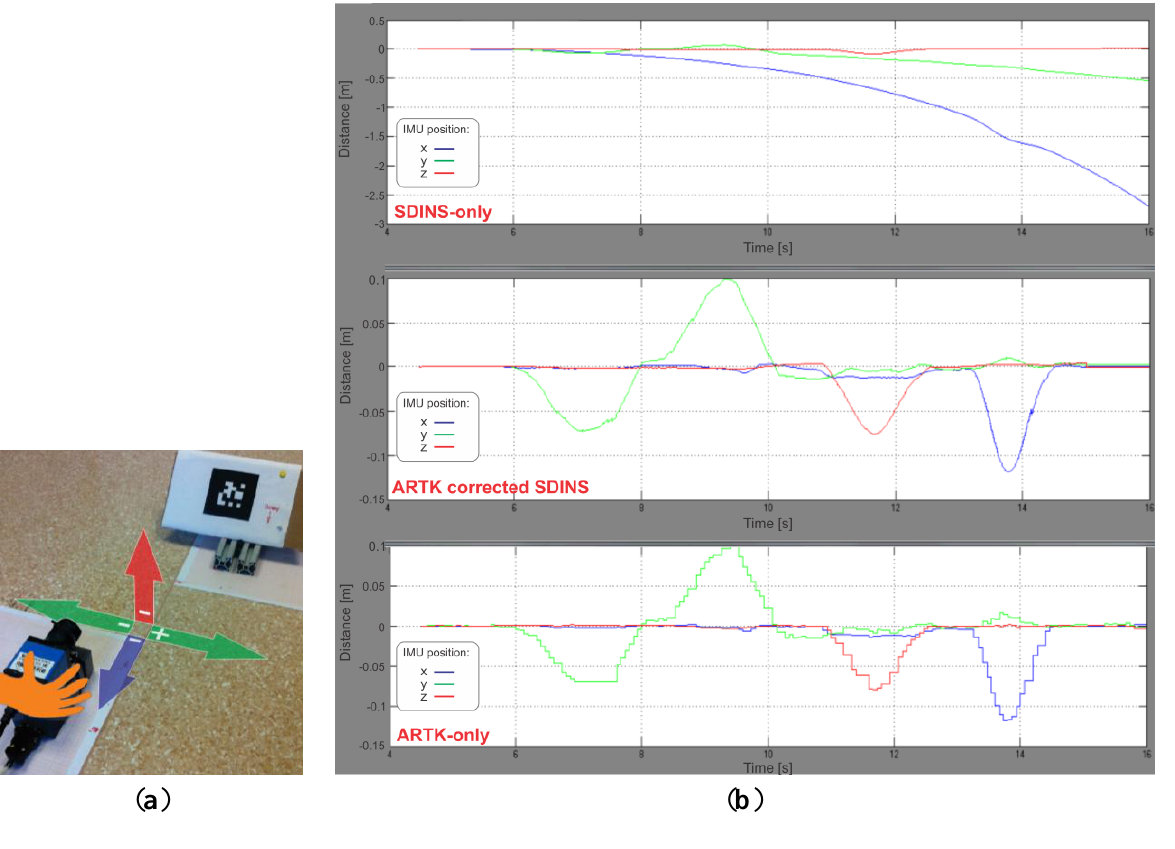
Figure 6. ( a ) Our first experimental setup. The IMU-Camera unit facing the fixed marker on the floor with arrows showing the directions of the movements completed, which coincide with the navigation frame axes in this case. The colors of the arrows and the imprinted signs are consistent with the curves, plotted on the graphs on the right. ( b ) Simulation results of the preliminary